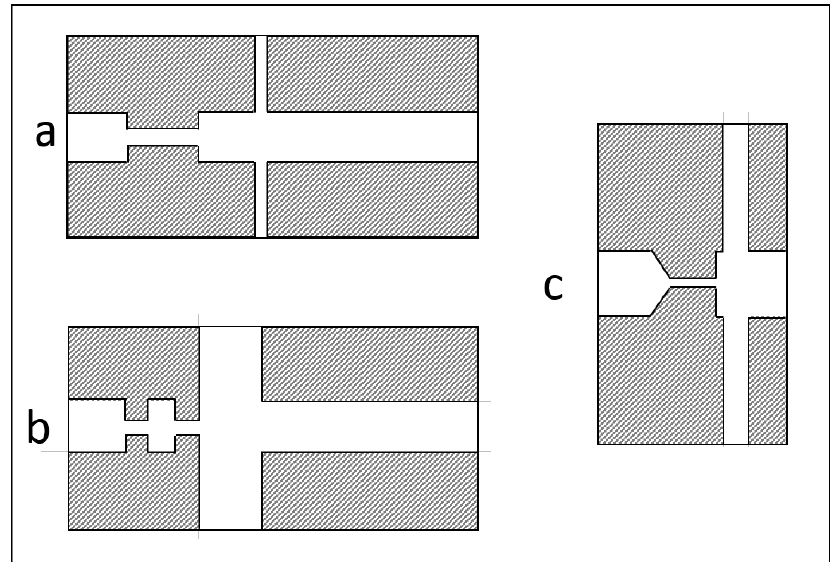
Figure 5. SEM valves. ( a ) orifice SEM valve adapted from [4]; ( b ) double SEM valve adapted from [58]; ( c ) SEM valve with modified inlet geometry adapted from [55].